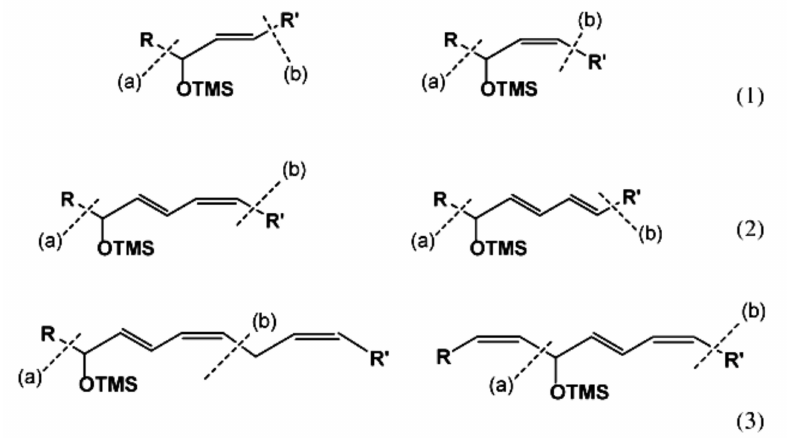
Figure 20. Mass-fragment ions obtained by GC-MC of trimethylsilyl (TMS) derivatives of oleate ( 1 ), linoleate ( 2 ), and linolenate ( 3 ) ((a) denotes α -scission and (b) allylic fragmentation). Reprinted with permission from [10]. Copyright 2005, Elsevier Science; Woodhead